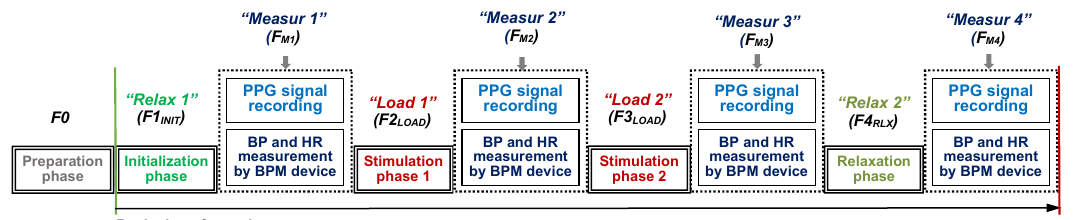
Figure 3. Principal measurement schedule applied in all performed experiments. BPM, blood pressure monitor; HR, heart rate.